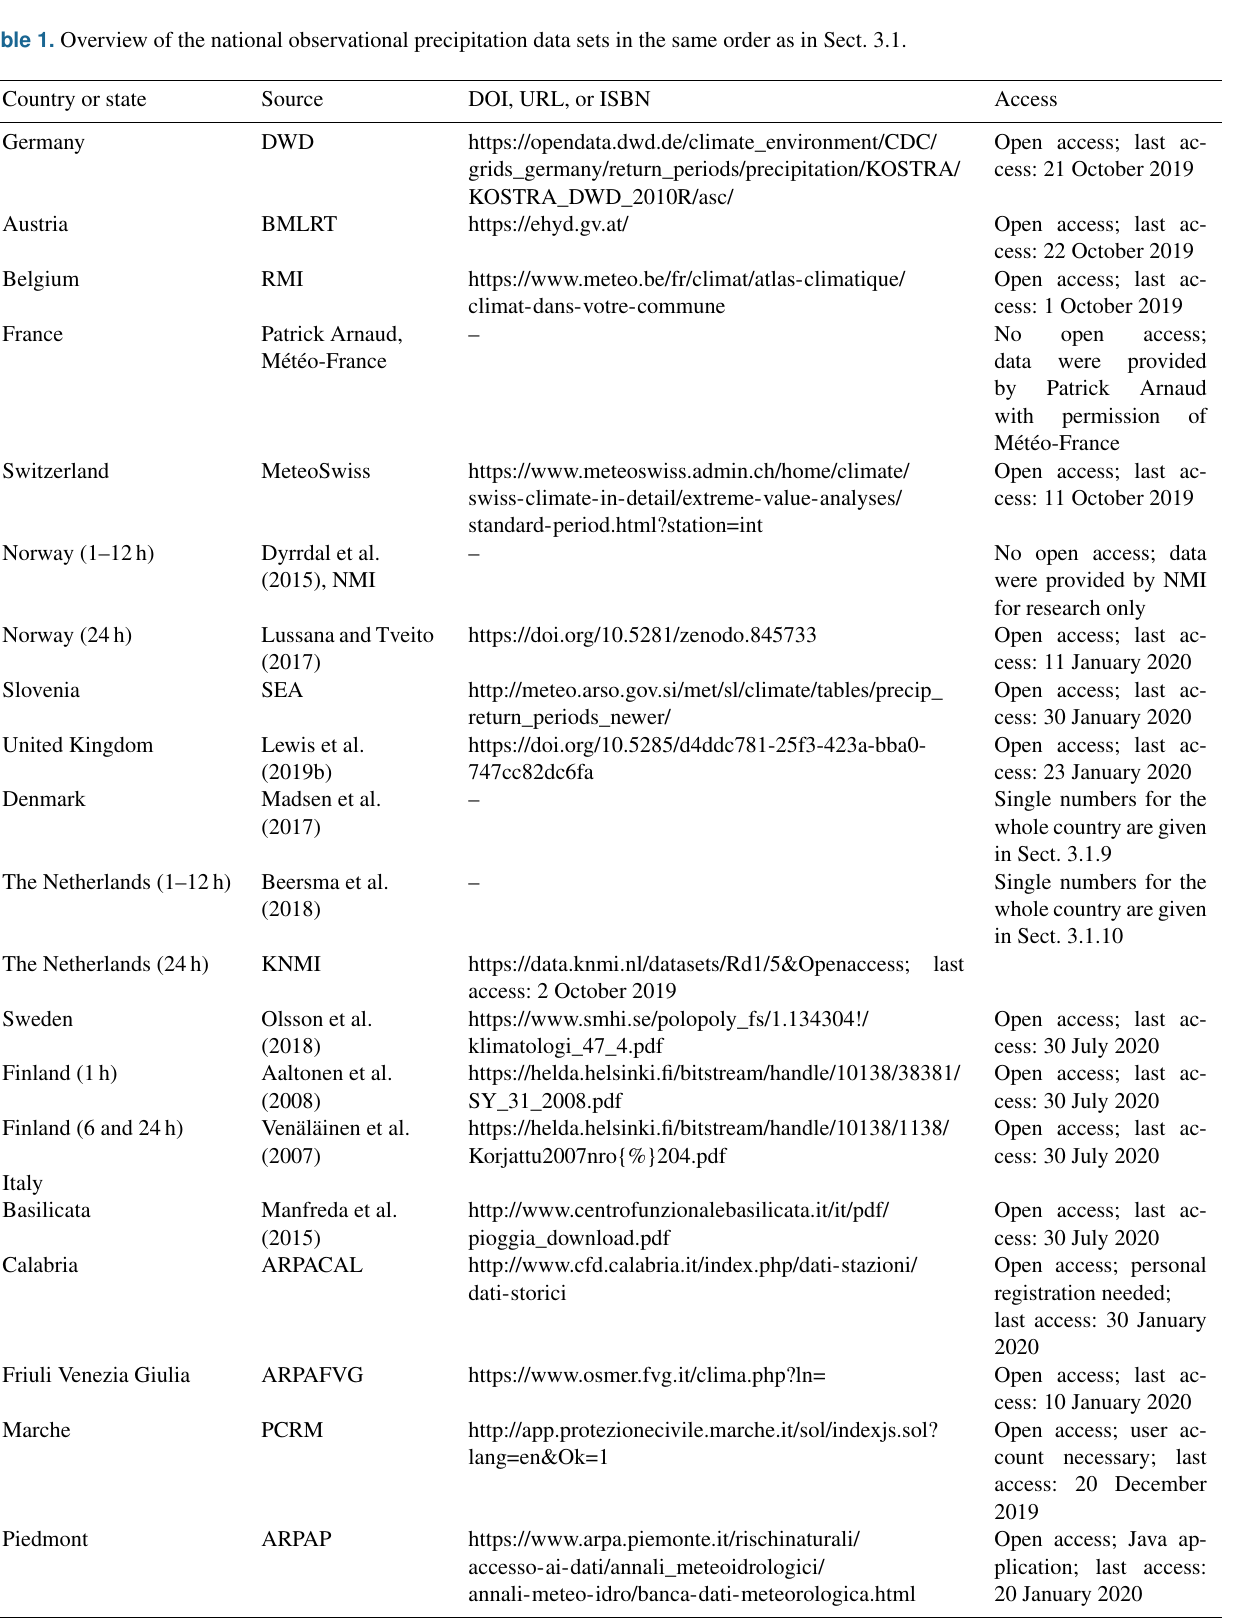
Table 1. Overview of the national observational precipitation data sets in the same order as in Sect. 3.1. Country or